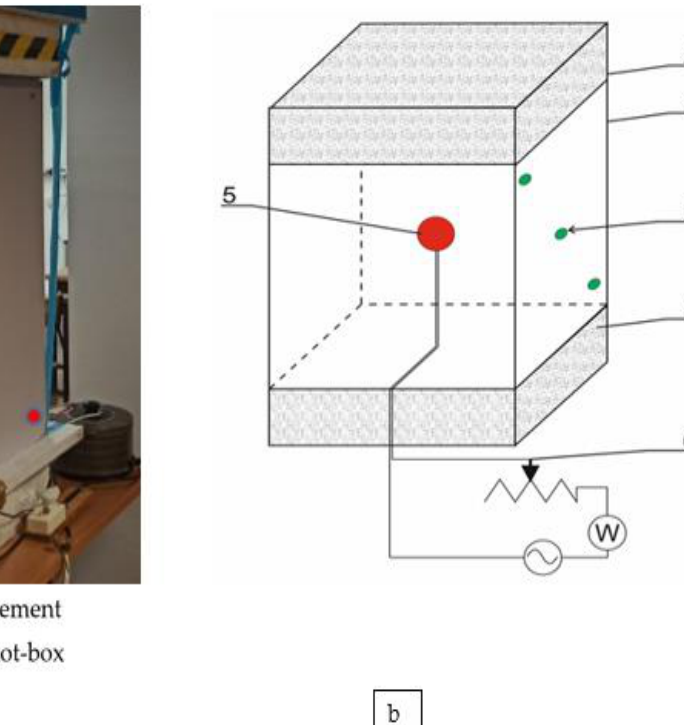
Figure 3. ( a ) Photo of the “hot-box”; ( b ) Test stand—“hot box” measuring cube: 1—measuring walls, 2—insulation of the upper wall, 3—position of the temperature measuring points on the side walls, 4—insulation of the lower wall, 5—heat source (radiation), 6—heat source power control system.